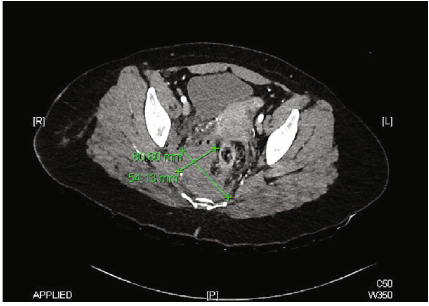
Figure 1: Presacral hematoma in the pelvic CT.